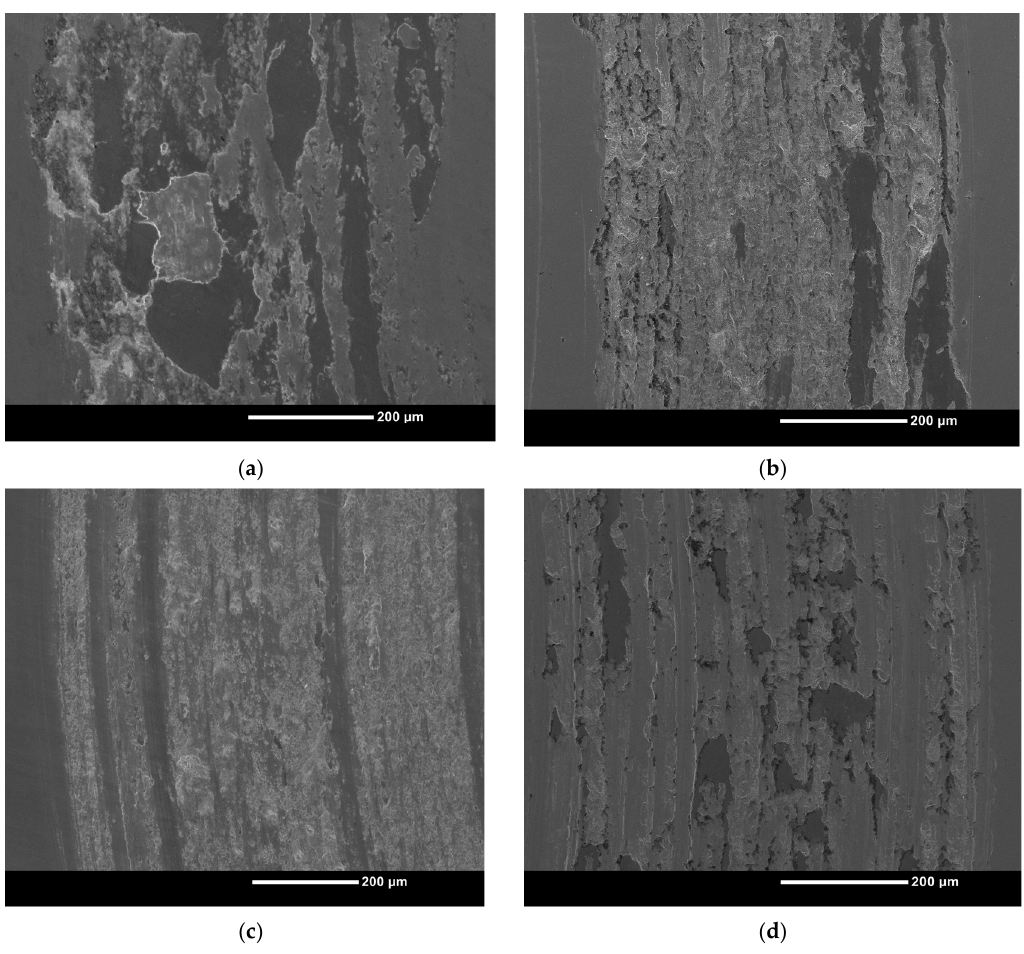
Figure 14. SEM images of the wear areas of Hf-N coatings deposited on Inconel 718 steel substrates as a function of temperature ( a ) 100 °C, ( b ) 200 °C, ( c ) 400 °C, and ( d ) 800 °C.